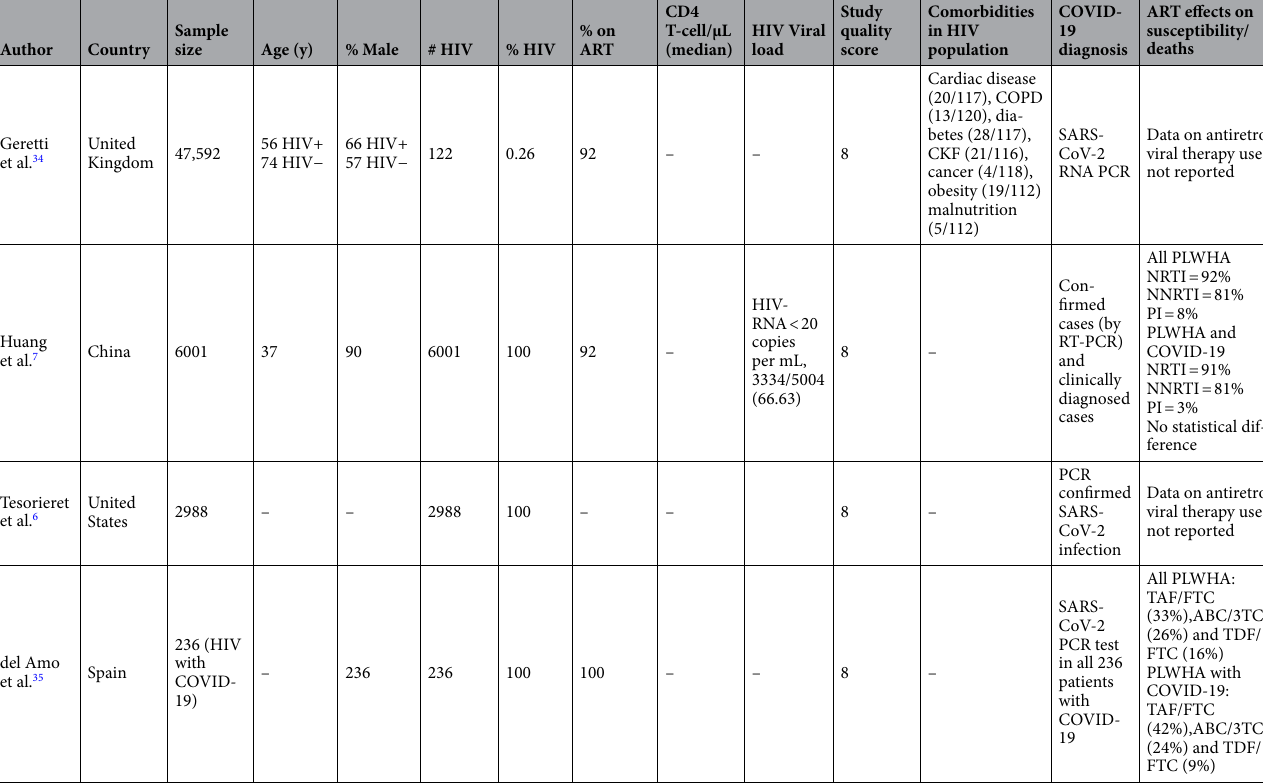
Table 1. Summarized study-level patient sociodemographic characteristics. ART: antiretroviral therapy; NRTIs: nucleos(t)ide reverse transcriptase inhibitors; NNRTI non-nucleoside reverse transcriptase inhibitors; TDF: tenofovir disoproxil fumarate; TAF: tenofovir alafenamide; FTC: emtricitabine; DOR: doravirine; DRV: darunavir; DTG: dolutegravir; 3TC: lamivudine; PI: protease-inhibitor; HTN: hypertension; CKD: chronic kidney disease. PCR: polymerase chain reaction; Hep: Hepatitis; HCV: Hepatitis C virus; RT-PCR Reverse transcription Polymerase Chain Reaction; CLD: Chronic Liver Disease; NSTI, integrase strand transfer inhibitor; PLWHA; persons living with HIV/AIDS.